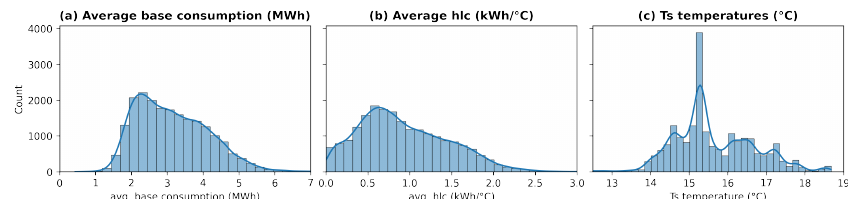
Figure 4. Aggregated distributions of main variables at national scale.